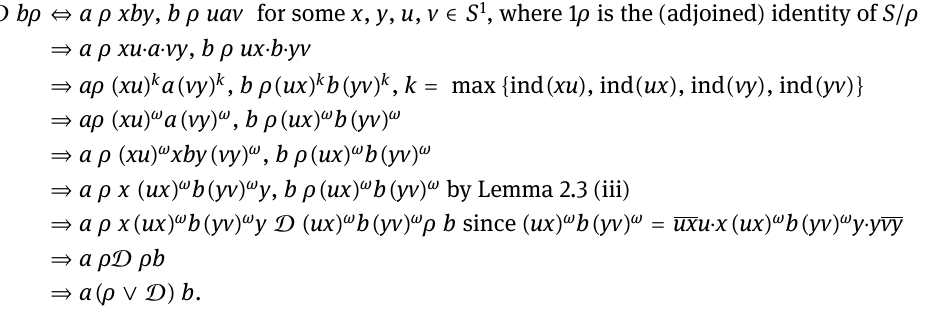
is a partition π of S . Let ρ be the equivalence on S 1 1